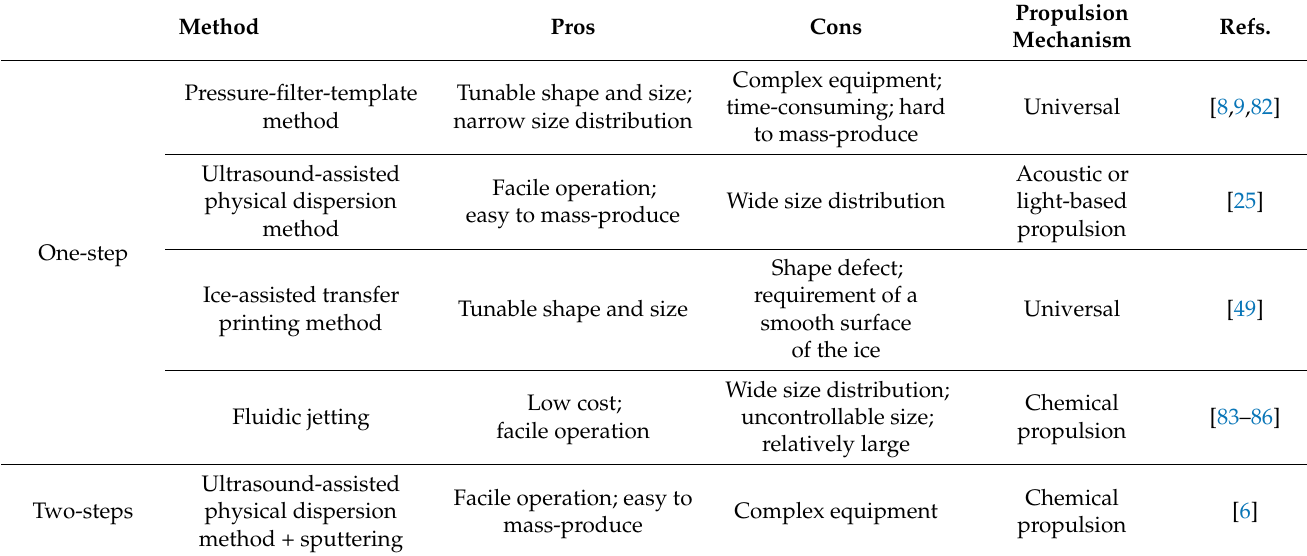
Table 3. Fabrication methods for